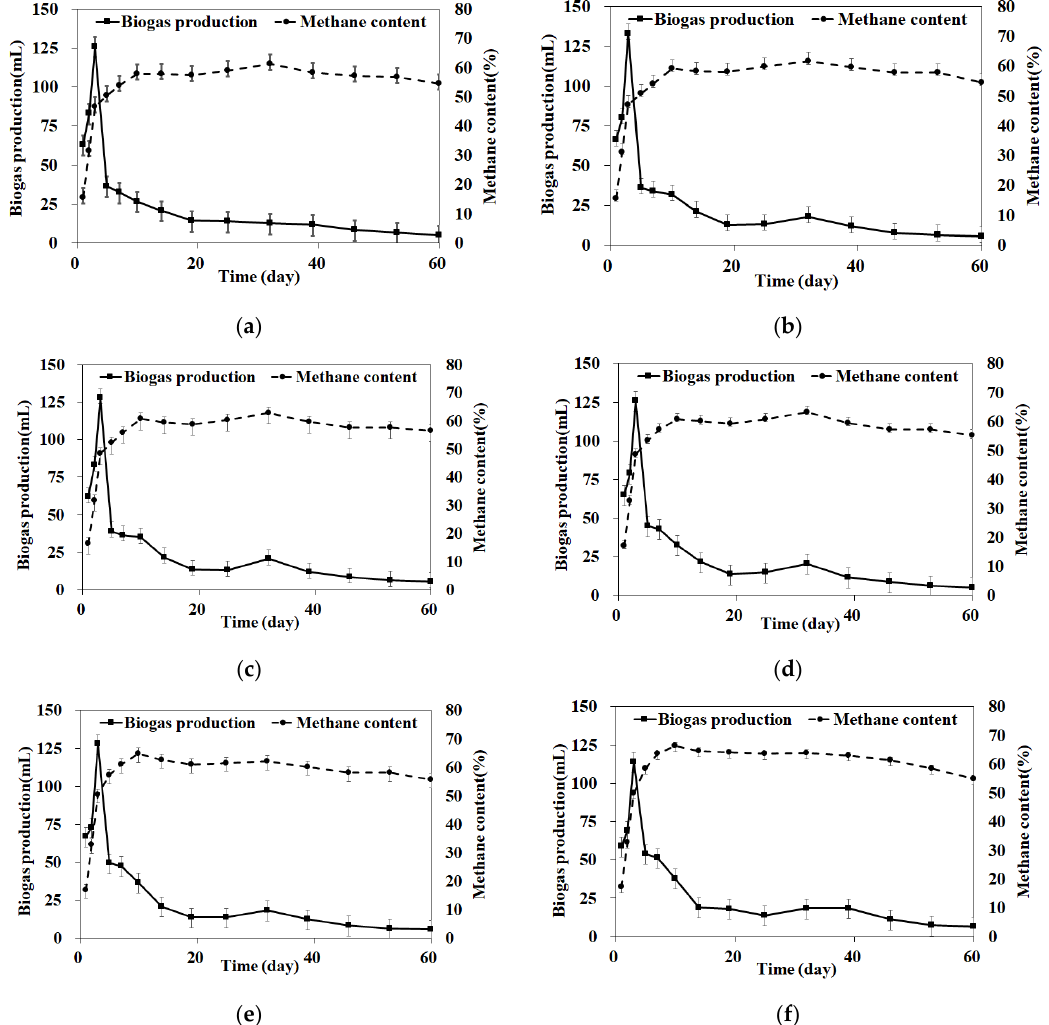
Figure 2. Methane content by condition (biochar content); ( a ) control 0%, ( b ) 0.1%, ( c ) 0.5%, ( d ) 1.0%, ( e ) 3.0%, ( f ) 5.0%.